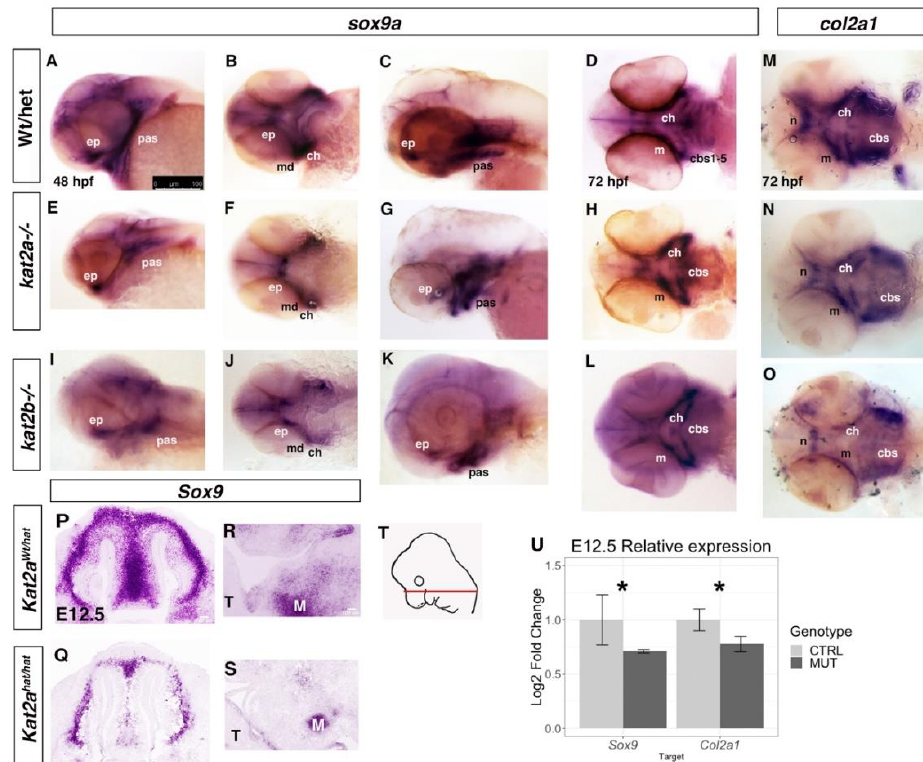
Figure 3. Cartilage progenitor expression of sox9 and col2a1 is reduced in kat2a − / − and kat2b − / − zebrafish embryos and E12.5 Kat2a hat/hat mice. Whole-mount in situ hybridization for zebrafish sox9a ( A – L ) and col2a1 ( M – O ) in wildtype or heterozygous embryos ( A – D , M ), kat2a − / − ( E – H , N ), and kat2b − / − ( I – L , O ) zebrafish embryos at 48 hpf ( A , B , E , F , I , J ) and 72 hpf ( C , D , G , H , K – O ). Lateral views ( A , C , E , G , I , K ), and ventral views ( B , D , F , H , J , L – O ), with the anterior to the left in all cases. At both stages, sox9a and col2a1 expression is reduced in the forming cartilage elements. At 48 hpf, there is an overall reduction, especially in the anterior expression domain of sox9a ( E , F and I , J as compared to control ( A , B )). At 72 hpf, the number of cartilage elements is reduced, especially in the ceratobranchial cartilages in both kat2a ( G , H , N ) and kat2b ( K , L , O ) as detected with both sox9a and col2al . For sox9 , n = 8/33 for kat2a , n = 7/30 for kat2b . For col2a1 , n = 7/29 for kat2a , n = 7/31 for kat2b . ( P – S ) Sectional in situ hybridization with a Sox9 antisense probe on mouse E12.5 Kat2a Wt/hat ( P – R ) and Kat2a hat/hat ( Q – S ) cryosections through the frontonasal prominence ( P , Q ) and the mandibular prominence ( R , S ) as schematized in the diagram of a E12.5 embryo adapted from the eHistology Atlas (T, the red bar indicates the plane of transverse sections). M = Meckel’s cartilage, T = Tongue. ( U ) RT-qPCR quantification of Sox9 and Col2a1 expression with RNA extracted from the facial prominences of control ( Kat2a Wt/hat ; CTRL on graph) and mutant ( Kat2a hat/hat ; MUT on graph) E12.5 mouse embryos. Expression was normalized to GusB, n = 4. The Y-axis shows the Log2 fold change of the relative gene expression, following the ddCT method; * denotes statistical significance ( p < 0.05) using Welch’s t -Test. The error bars show the standard error of the mean. cbs1-5, ceratobranchials 1-5; ch, ceratohyal; ep, ethmoid plate; m, Meckel’s cartilage; n, neurocranium; pas, pharyngeal arches. The scale bars represent 100 μm.